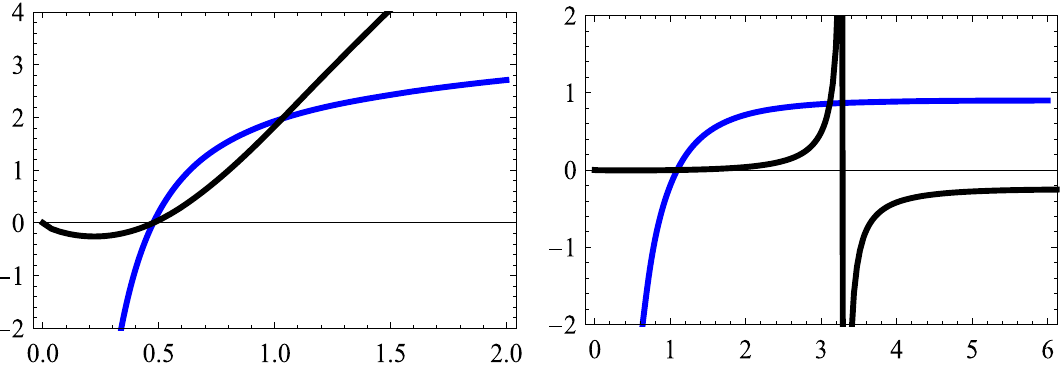
Fig. 3 T (blue) and H Q (black) versus r + for ν = − 2 1 . 06(black) , 1 . 13(blue) , 1 . 25(red). Right: a = 1 . 4 and α = 1 . 98(black) , 2 . 023(blue) , 2 . 08(red)